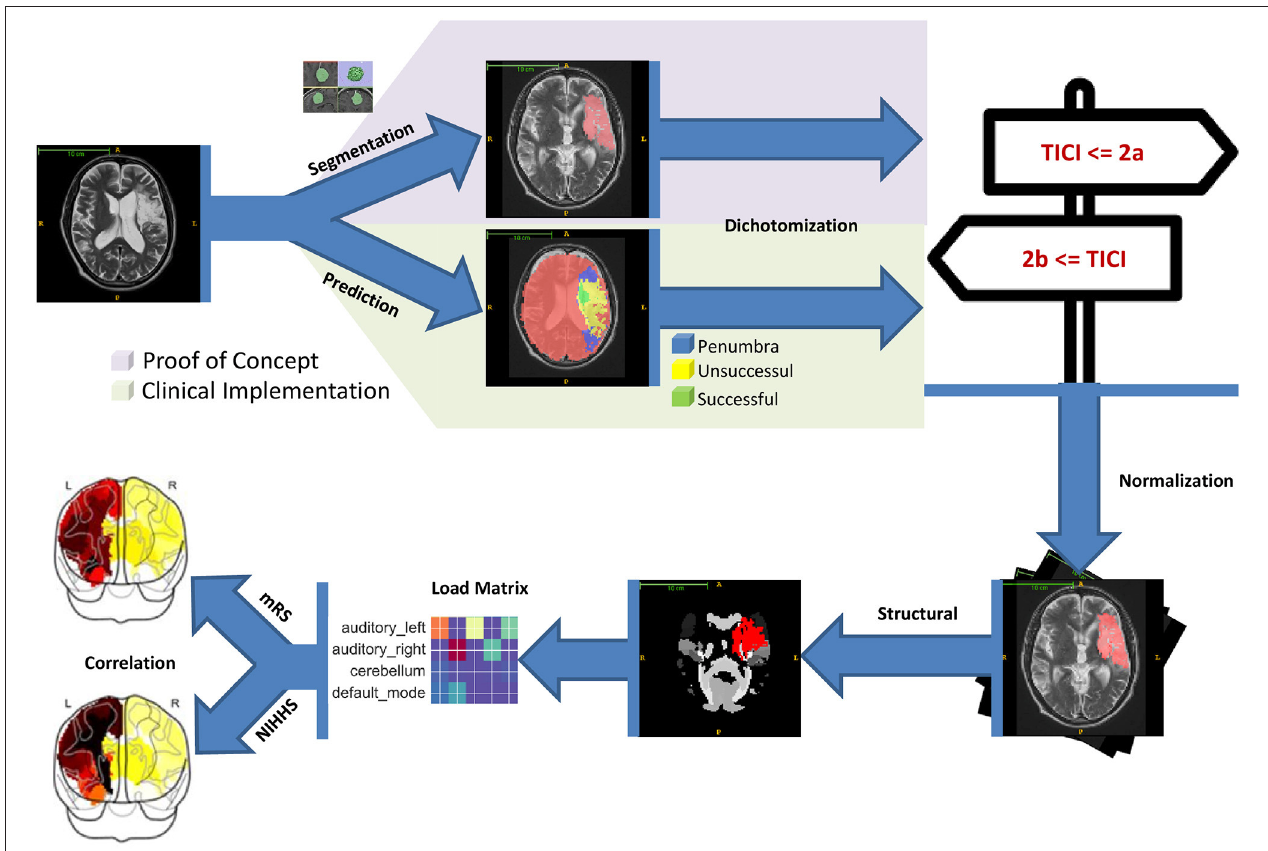
FIGURE 1 | Starting with the MRI imaging data lesion delineations were generated either manually or automatically. The former was used for proof of concept and the latter to show the proposed clinical implementation. The lesion delineations were then dichotomized into successful and unsuccessful revascularization groups according to the patient’s TICI scores. Image normalization was performed in a next step to make them conform to MNI152 space. With that, the lesion delineations were superimposed onto the structural atlas and lesion loads for every region computed. Finally, the lesion loads were correlated with the 3 month mRS and NIHSS scores.